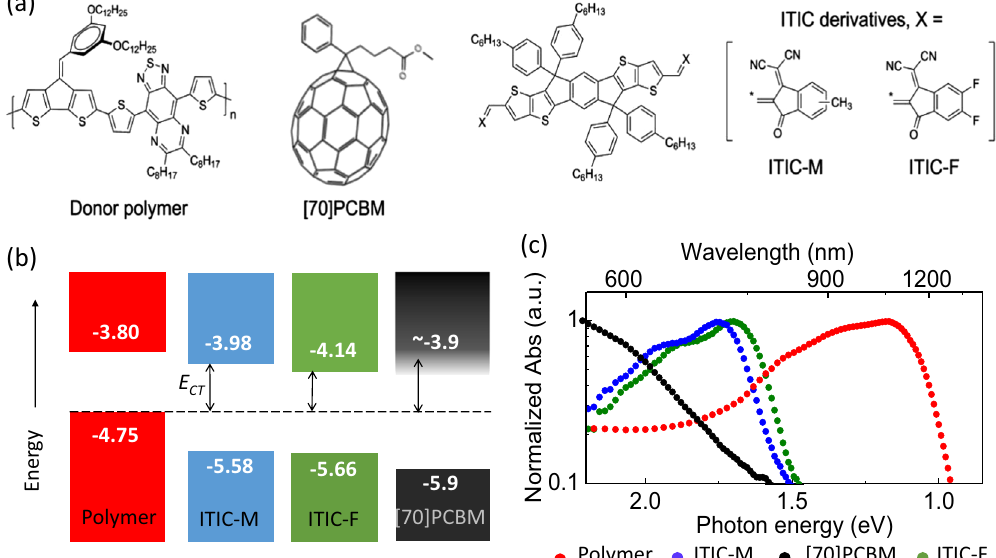
Fig. 1 Materials characteristics. a Chemical structures and b energy levels of an infrared donor polymer P1 with respect to different acceptors. c Normalized absorption spectra for pristine organic semiconductor fi